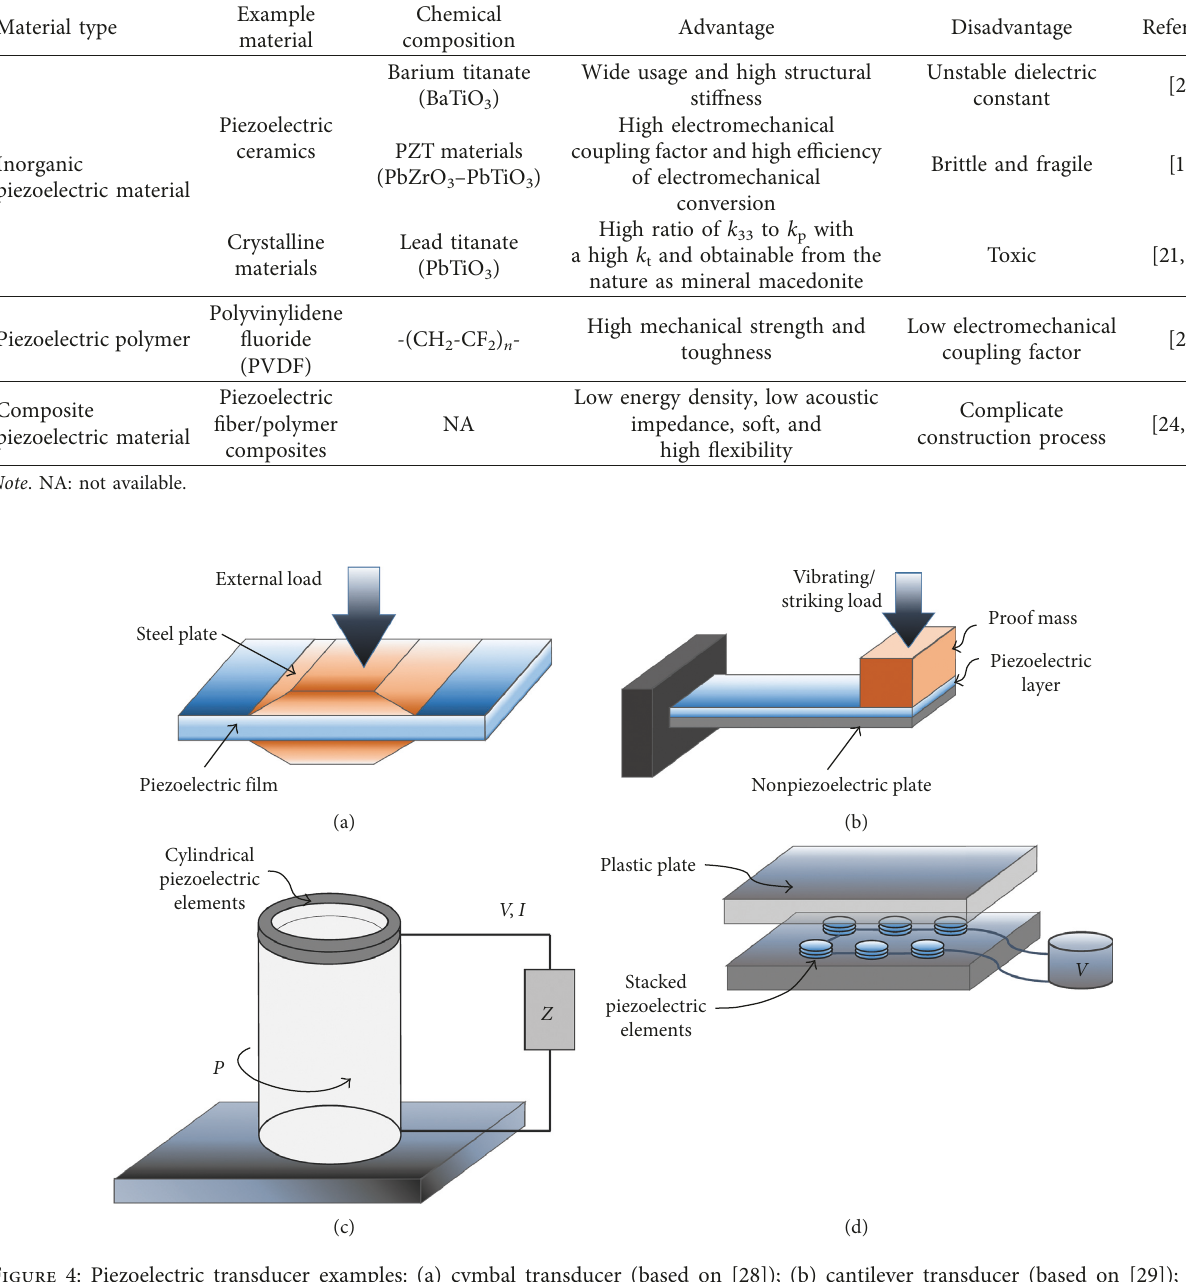
Table 1: Features of piezoelectric